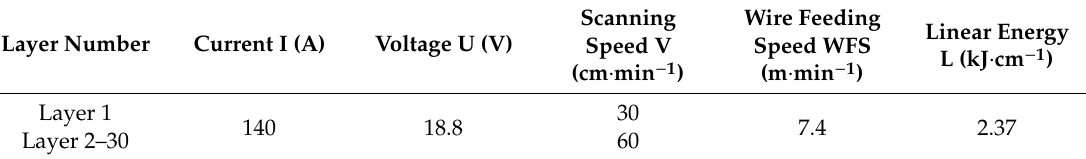
Table 2. Deposition process parameters.